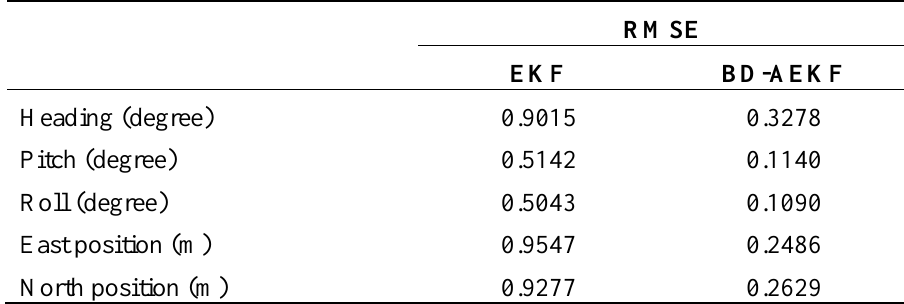
Table 11. Comparison of errors between EKF and BD-AEKF (Line).